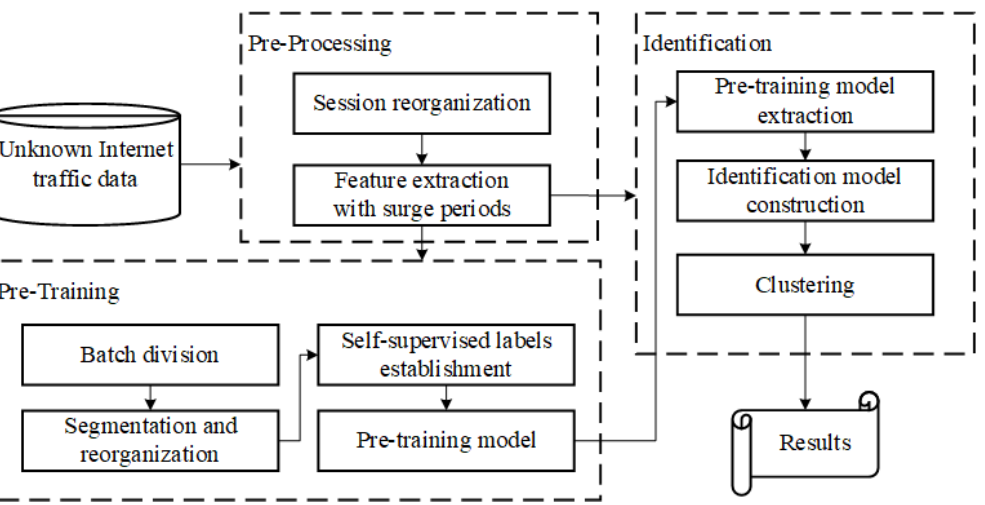
Figure 1. The main process of our proposed method of unknown Internet traffic